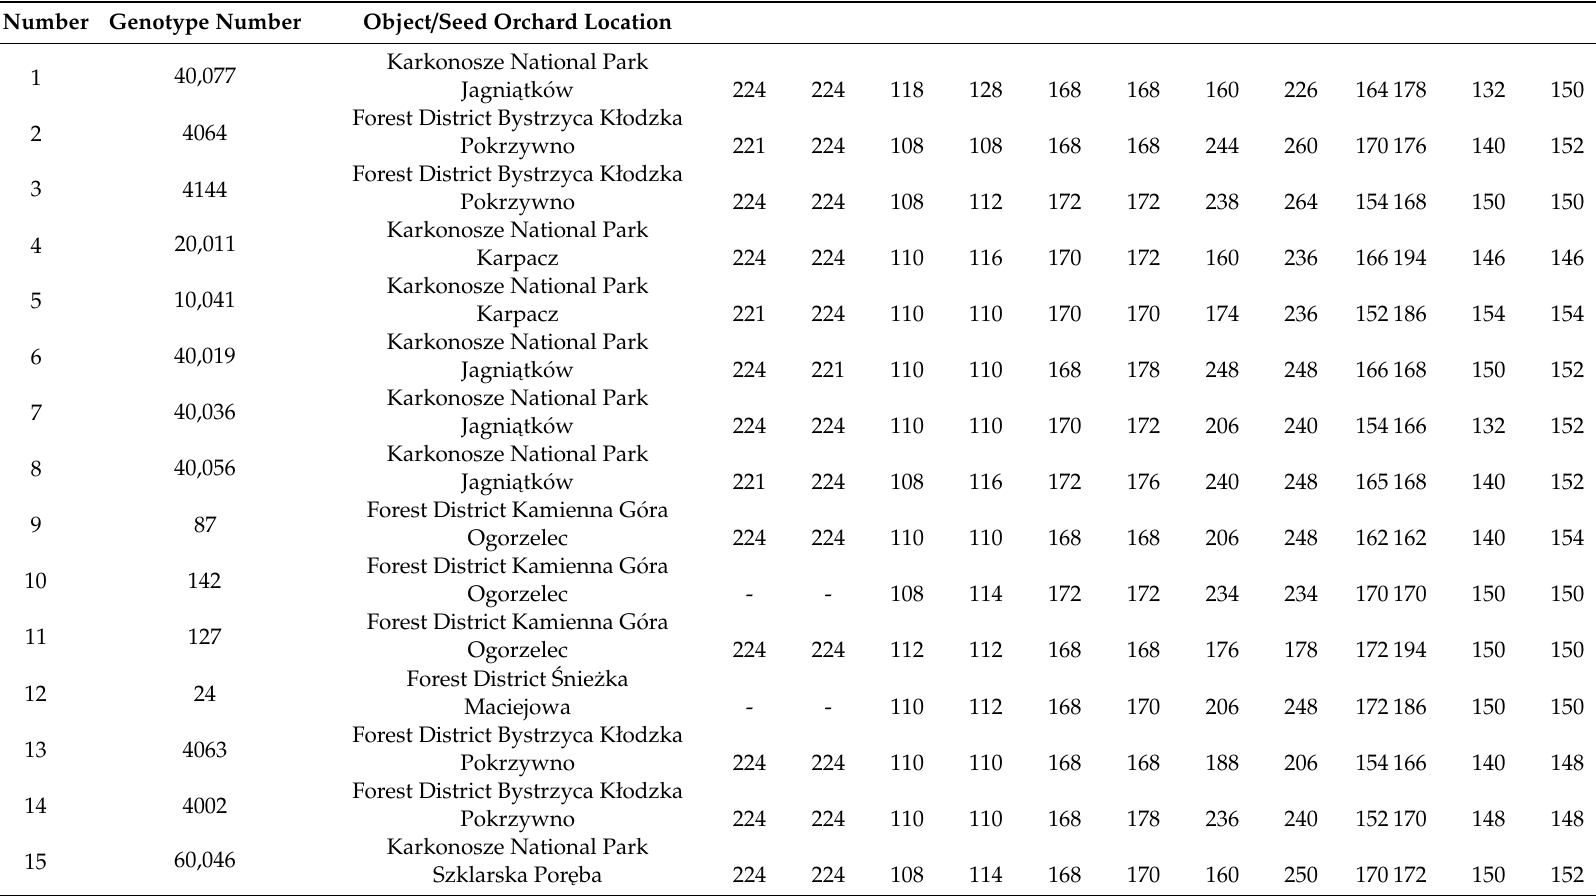
Table A1. The analysed pollen grains for the studied genotypes of Abies alba